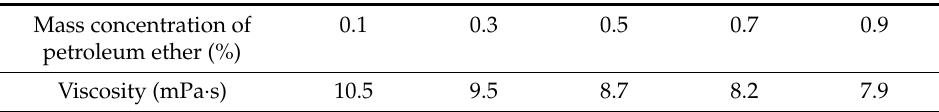
Table 4. Oil viscosities for the crude oil diluted with di ff erent mass concentrations of petroleum ether at the temperature of 70 ◦ C.